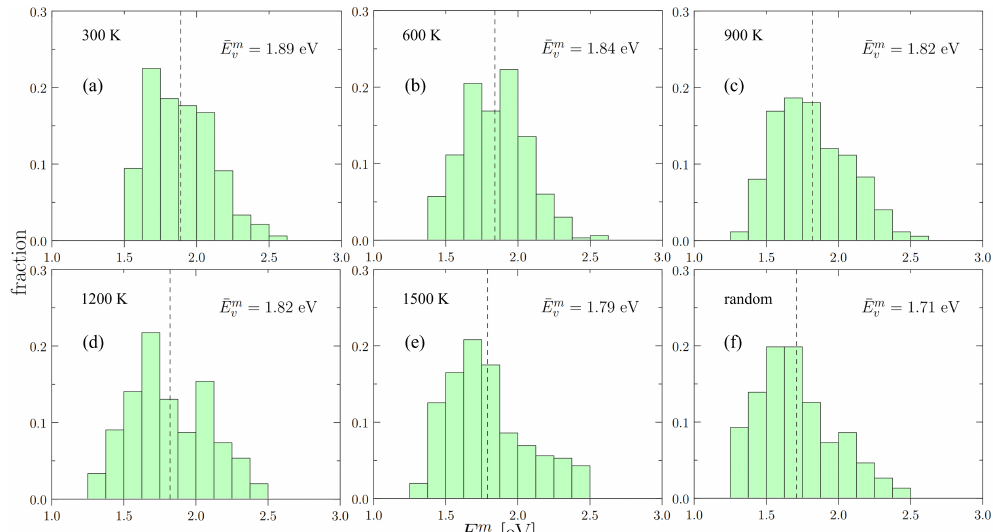
Figure 7. The distributions of vacancy migration energies of: ( a–e ) cells with short range order (annealing temperature from 300 K to 1500 K) and ( f ) the random cell of Nb-Mo-Ta-W. The dashed line shows the position of the statistical average of each distribution.